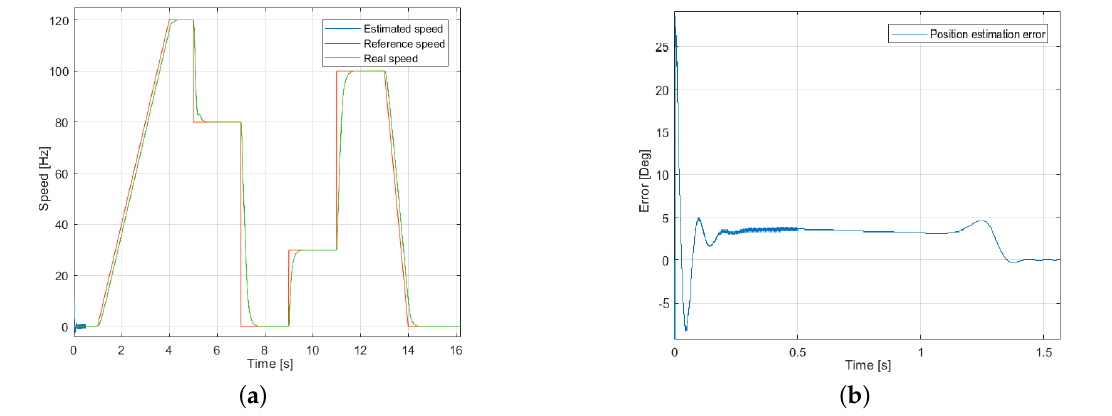
Figure 10. V-I observer estimator simulation. ( a ) Speed profile. ( b ) Position estimation error.